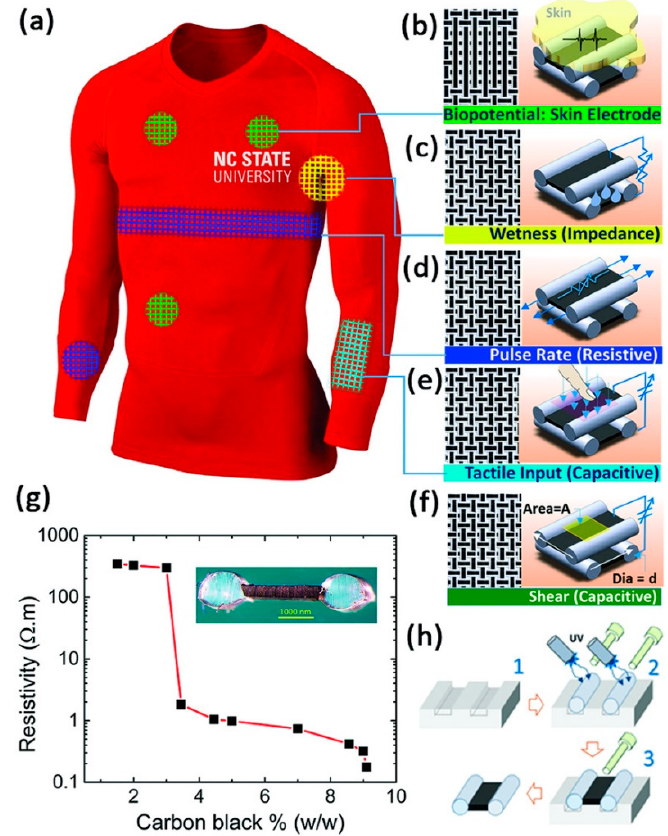
Figure 6. Multimodal sensor schematic ( a ) showing the five modes—biopotential ( b ), wetness ( c ), pulse rate ( d ), pressure (tactile input) ( e ), and shear ( f )—carbon black percolation threshold (( g ): inset shows fiber cross-section) and three step fiber casting method ( h ) [100]. Reproduced with permission from Adv. Mat. Tech. Copyright 2018 Wiley.